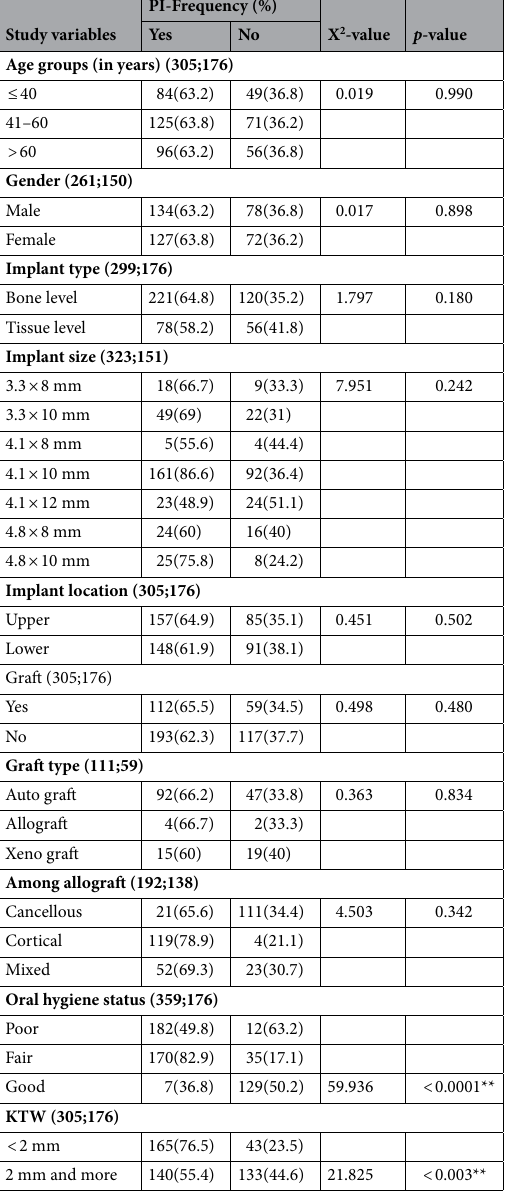
Table 2. Association between PI and other study variables. *Keratinized tissue width. **Statistically